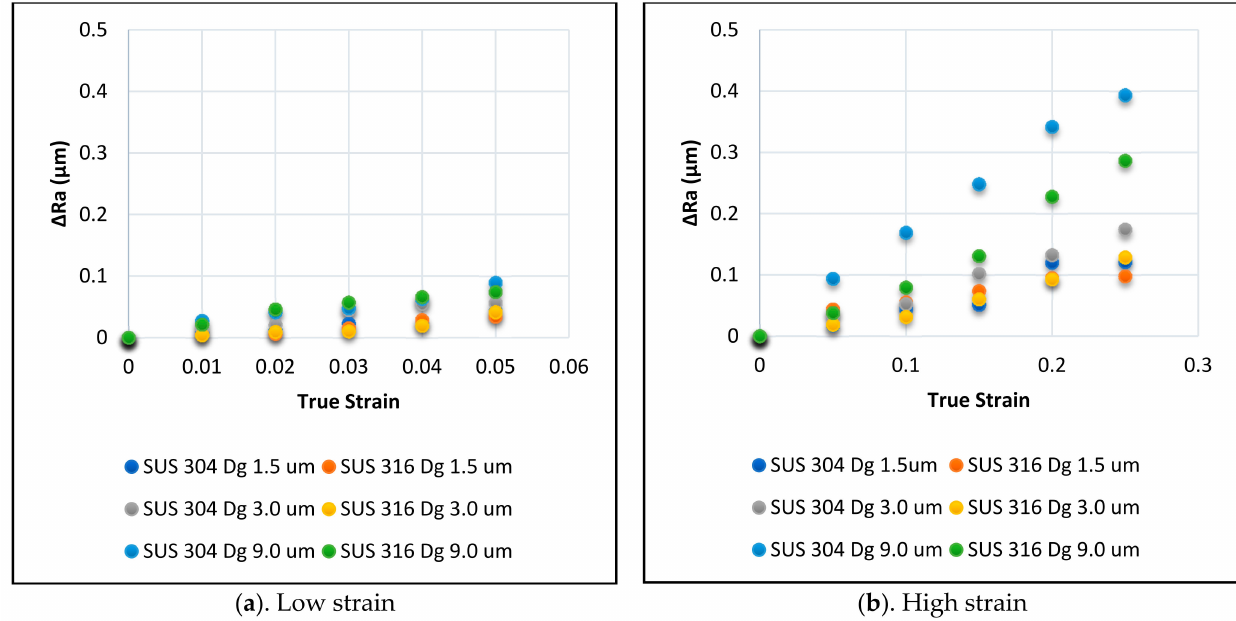
Figure 5. The increase in surface roughening behavior in SUS 304 and SUS 316, low strain ( a ) and high strain ( b ). Figure 6 indicates the ∆ Ra values for SUS 304 and SUS 316 thin metal foils at a high strain level with various grain sizes. The ∆ Ra increased proportional to Dg, but the